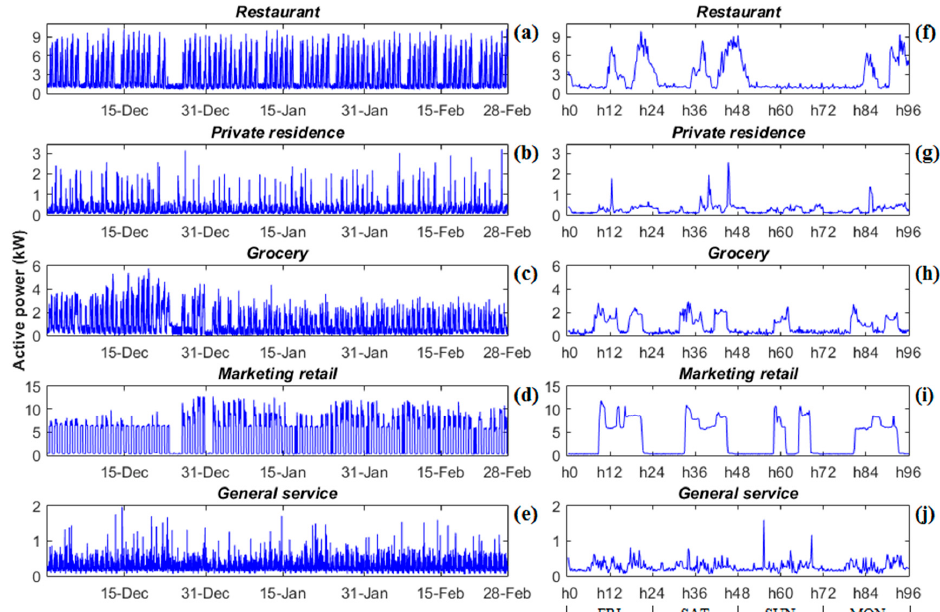
Figure 1. Example of temporal evolution of the active power absorbed by ( a ) a restaurant; ( b ) a private residence; ( c ) a grocery; ( d ) a marketing retail establishment; ( e ) a general service, for the whole measurements campaign. ( f – j ) Active power absorbed by the same users in a four day